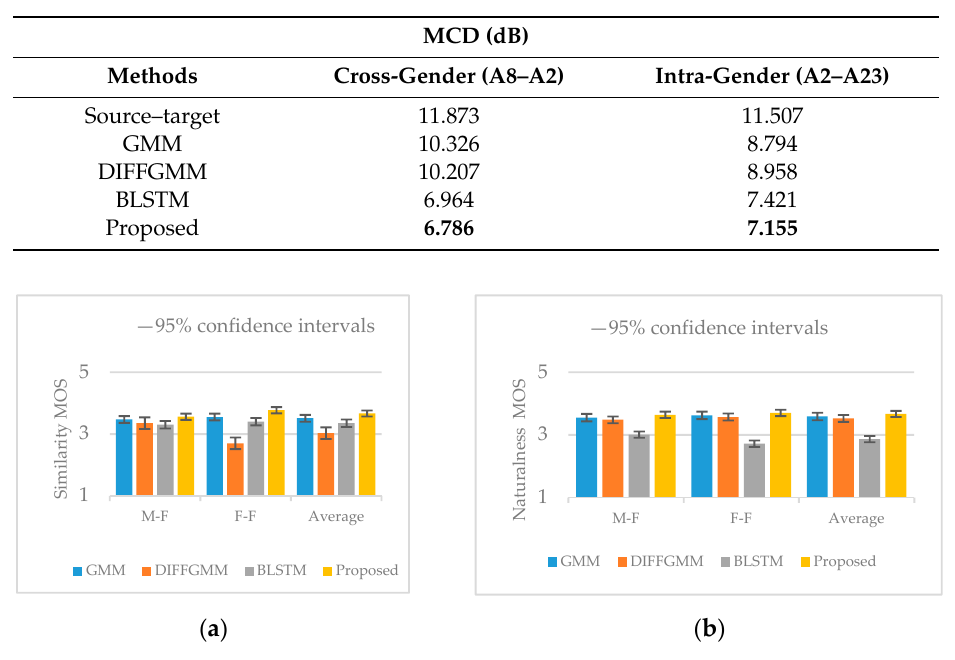
Table 2. Mean values of the MCD of all non-silent frames of the VC methods on the THCHS-30 dataset (15 dB babble added to source).